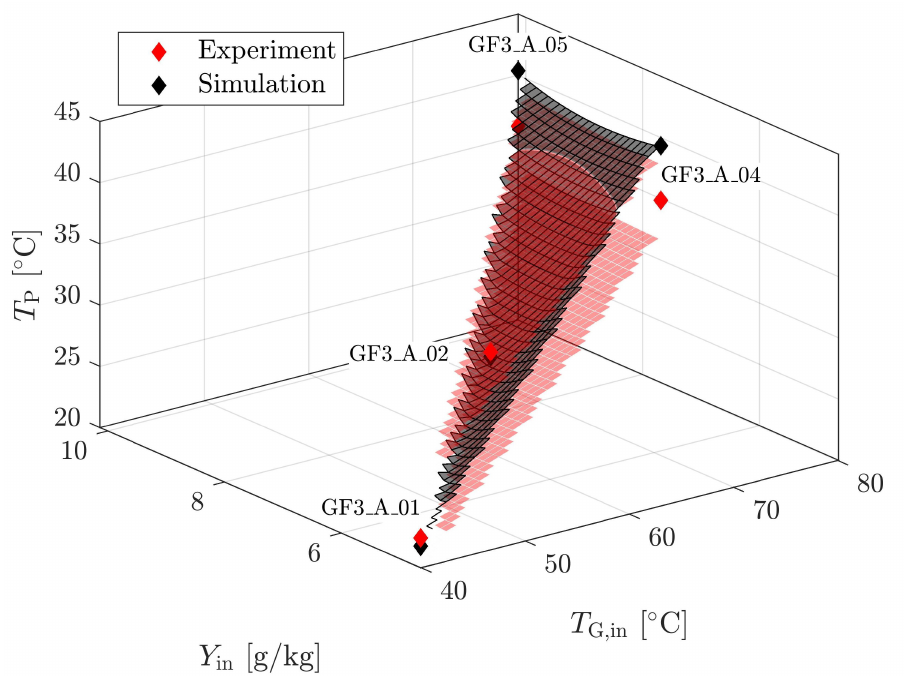
Figure 6. Comparison of measurements and model predictions of particle temperature ( T P ), plotted against drying temperature ( T G,in ) and inlet moisture content of air ( Y in ), in the GF3 lab-scale dryer for γ -Al 2 O 3 . The dark gray area designates model predictions; light red areas indicate the upper and lower boundary of measurement errors. Detailed information about the process conditions of the represented data points is given in Table 2.